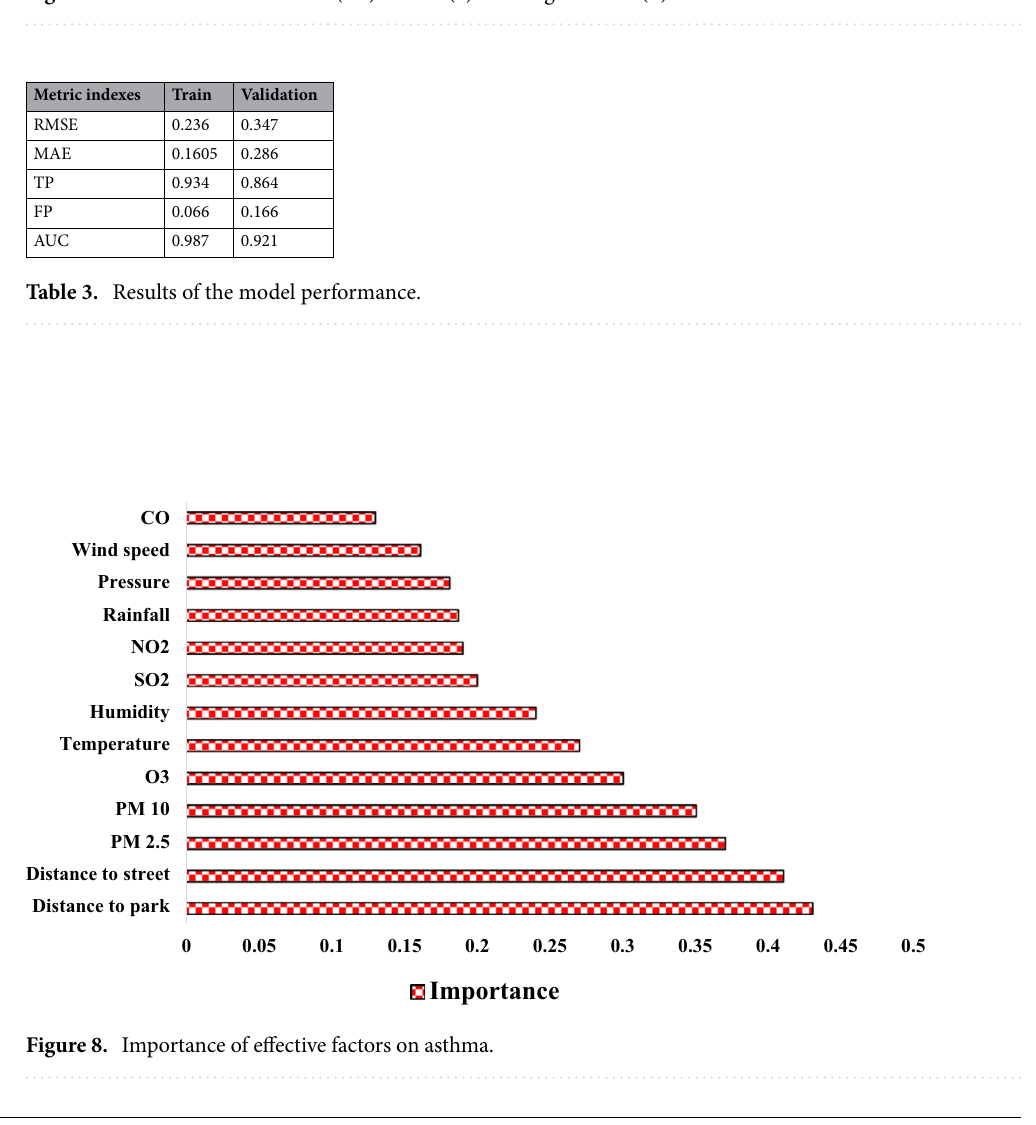
Figure 7. Result of random forest (RF) model. ( a ) Training data and ( b ) Validation data.